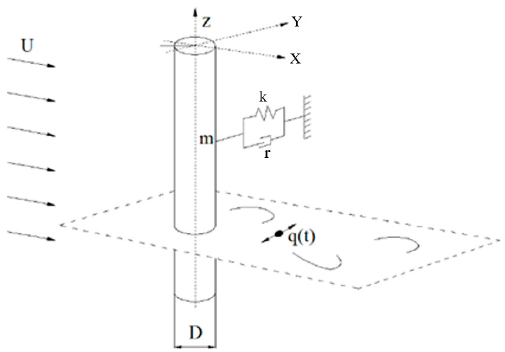
Figure 1. Model of vortex-induced vibration of elastically mounted cylinder coupled with wake oscillators [8].